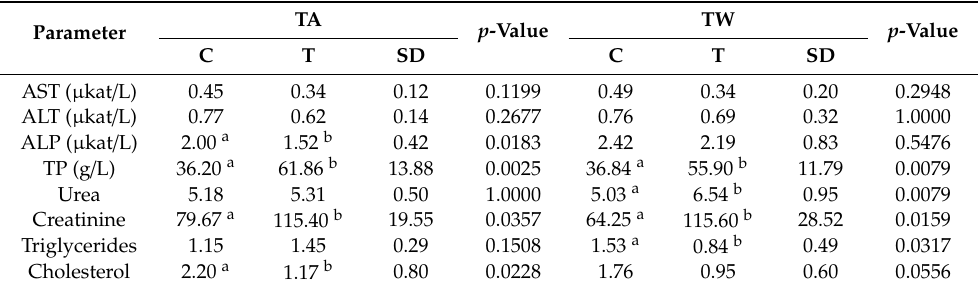
Table 3. E ff ects of thymol on aspartate aminotransferase (AST, µ kat / L), alanine aminotransferase (ALT, µ kat / L), alkaline phosphatase (ALP, µ kat / L), total proteins (TP, g / L), urea (mmol / L), creatinine ( µ mol / L), triglycerides (mmol / L) and cholesterol (mmol / L) in rabbit blood.